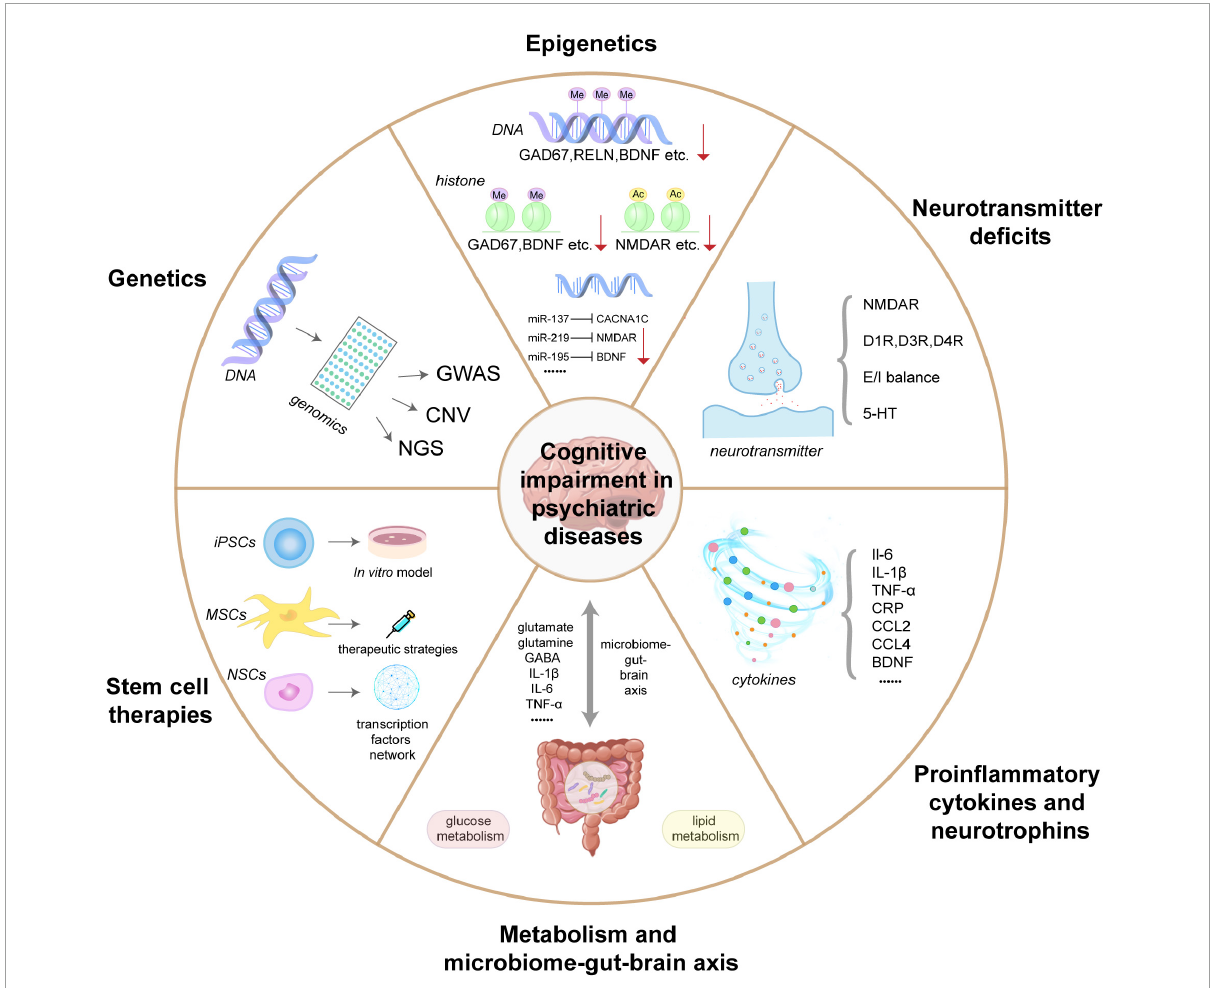
FIGURE1 An overview of the molecular mechanisms underlying cognitive impairment in psychiatric diseases. Genetic studies of psychiatric disorders usually include genome-wide association studies (GWAS), rare copy number variation (CNV) studies, and Next generation sequencing (NGS) studies. Genetics relies on variation and allele frequency data to infer essential risk genes and population genetic analyses for cognitive function; Epigenetics of cognitive impairment in psychiatric disorders include DNA methylation (GAD67, RELN, BDNF, etc.), histone modifications (GAD67, BDNF, etc.), and various microRNAs (miR-137, miR-219, and miR-195), which typically inhibits the expression of their targets; Neurotransmitters deficits involved in cognitive impairment of psychiatric disorders include the glutamatergic system (NMDAR), the dopaminergic neurotransmitter system (D1R, D3R, and D4R), gamma-aminobutyric acid (GABA) system (E/I balance), and serotonin system (5-HT); Peripheral inflammatory factors and neurotrophic factors associated with cognitive impairment in psychiatric disorders include IL-6, IL-1 β , TNF- α , CRP, BDNF, etc.; The metabolism and microbial gut-brain axis are critical bidirectional communication systems in cognitive impairment in psychiatric disorders; Stem cells (iPSCs, MSCs, and NSCs) provide an efficient in vitro modeling and therapeutic approach for the mechanism research of cognitive impairment in mental